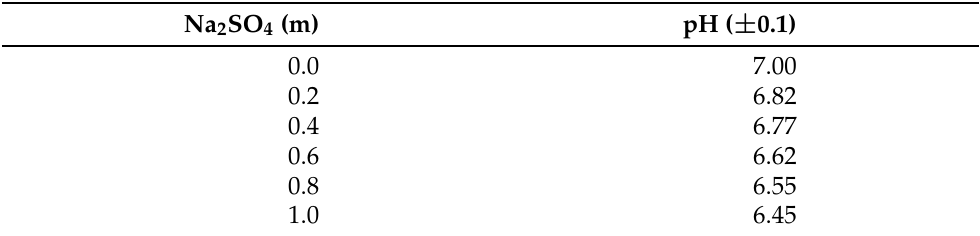
Table 1. Dependence of pH of the media on Na 2 SO 4